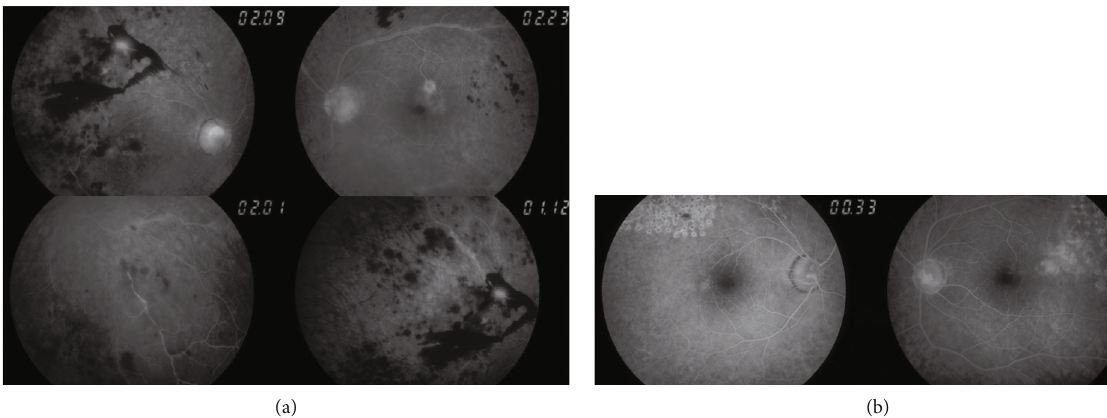
Figure 3: Fluorescein angiography showing (a) retinal venous vasculitis, perivascular hemorrhages, and severe retinal ischemia in both eyes in patient 2 and (b) after treatment, including scatter laser photocoagulation. Table 2: Disease severity classi fi cation system [13].